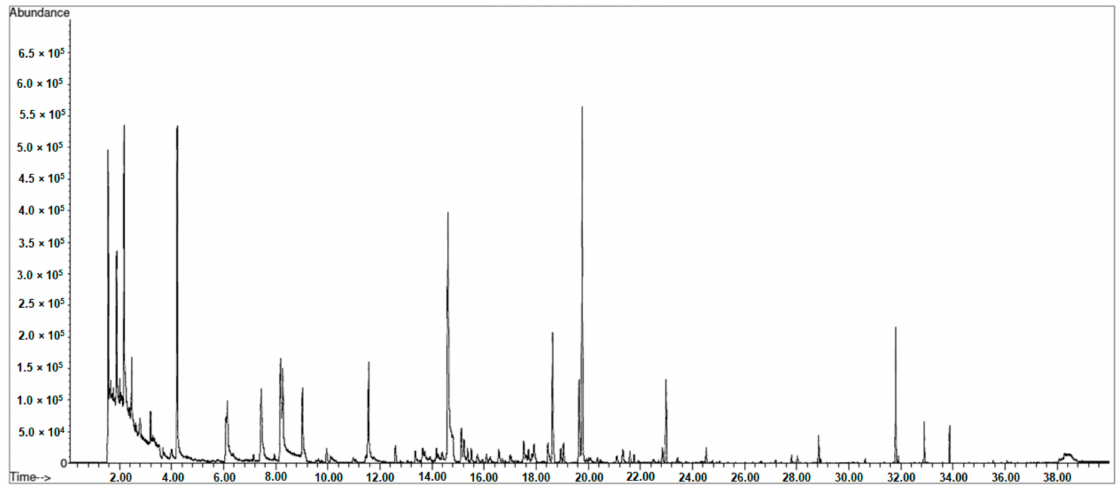
Figure 2. Illustrative TIC of volatile organic compounds in a caviar sample corresponding to a ripening time of 240 days (t4) by mean of